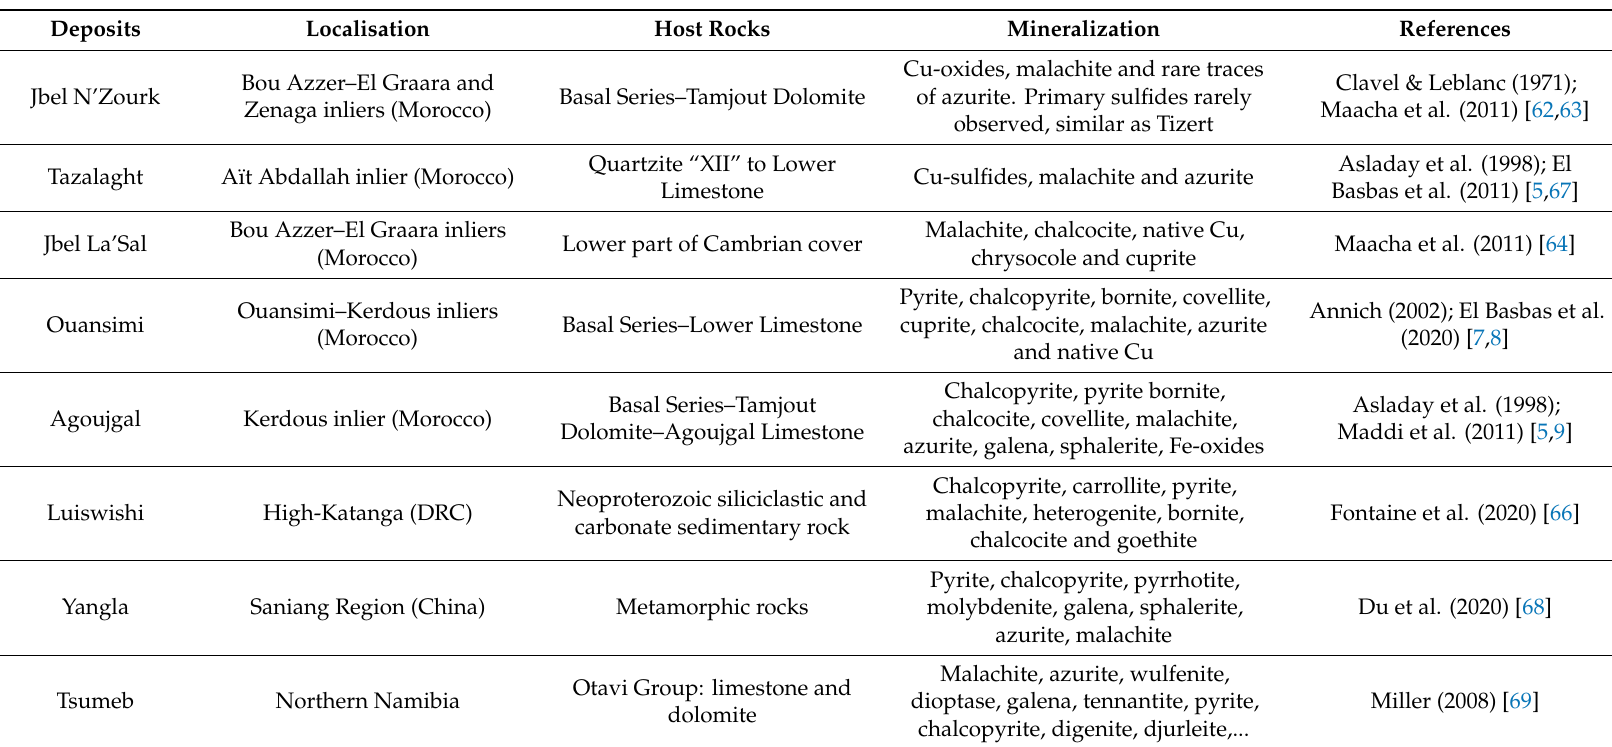
Table 3. Supergene malachite and azurite occurrences in some Cu-deposits in Morocco and around the